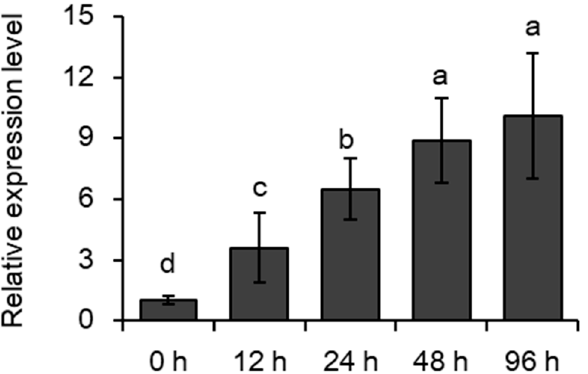
Figure 2. The transcription of MYB102 in response to aphid infestation. Quantitative Real Time- Polymerase Chain Reaction (qRT-PCR) analysis of MYB102 expression relative to that of ACTIN2 in uninfested and aphid-infested leaves of Arabidopsis plants carrying pMYB102:GUS at the indicated time post-infestation. Values are mean ± SD (standard deviation), n = 3. Different letters above bars denote significant difference among different treatments using Tukey’s test at p < 0.05.